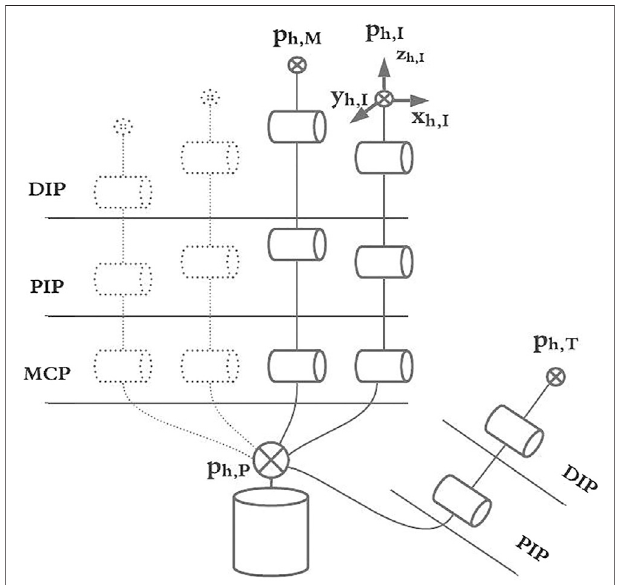
FIGURE5| Thesimpli fi edkinematicmodelofthehumanhand,structure with links, joints, base, and rotation axes are in evidence.